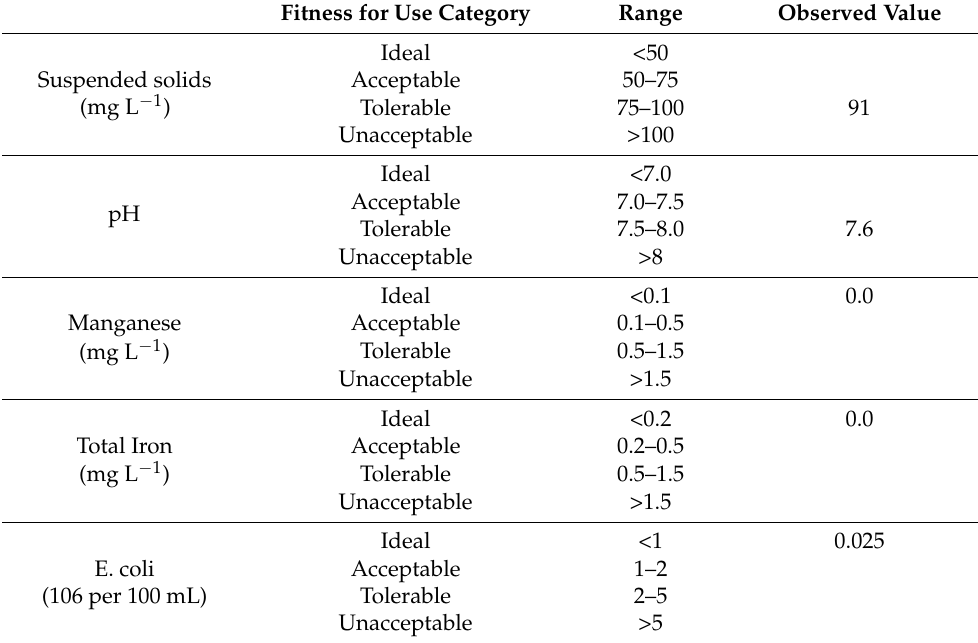
Table 7. The fitness for use of AF effluent based on selected characteristics that cause clogging of drippers.